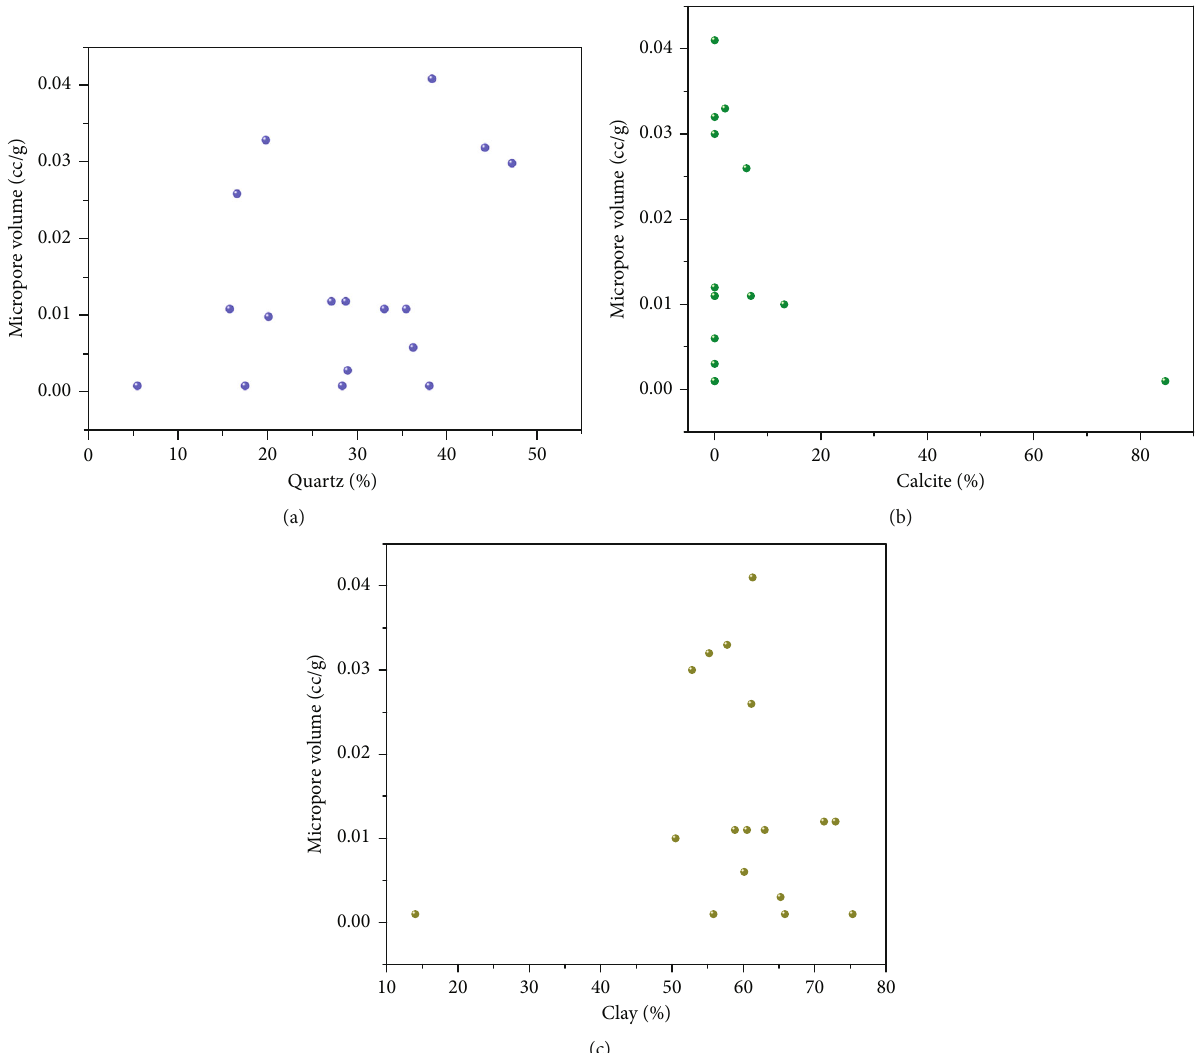
Figure 7: The correlation of micropore volume with di ff erent minerals of the Shanxi Formation and Taiyuan Formation, Ordos Basin. (a) Correlation between quartz and micropore volume. (b) Correlation between calcite and micropore volume. (c) Correlation between clay minerals and micropore